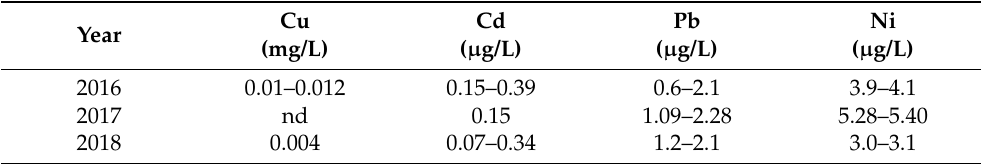
Table 3. Average values of specific indicators and their compounds from 2016–2018. Based on data from the Environmental Protection Inspection obtained by the State Environmental